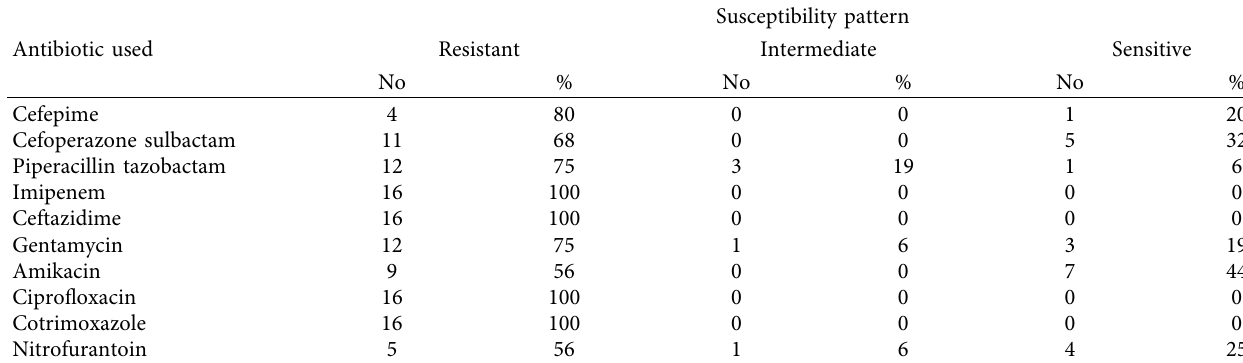
Table 5: Antibiotic resistance pattern of MBL producers.